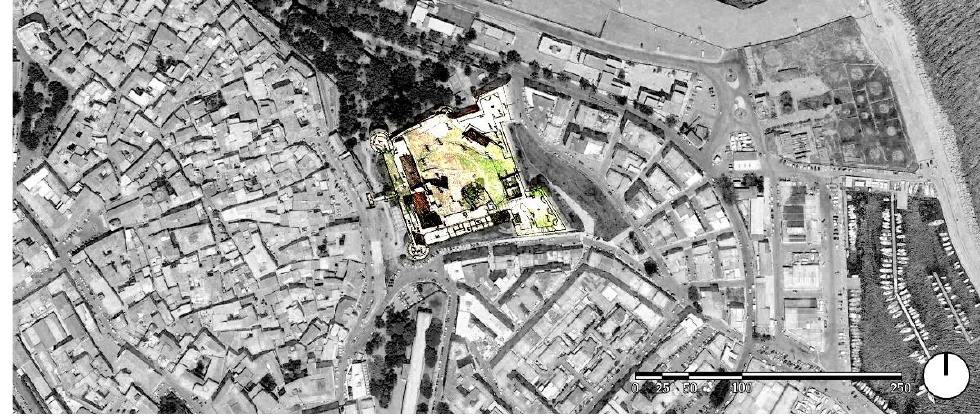
Figure 5. Territorial overview of the castle’s neighbourhoods with archival image overlay.